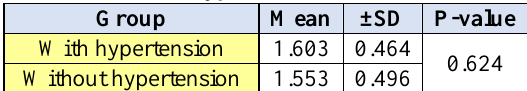
Table 1: Plaque index mean and standard